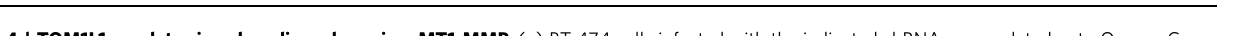
Figure 4 | TOM1L1 regulates invadopodia and requires MT1-MMP. ( a ) BT-474 cells infected with the indicated shRNAs were plated onto Oregon Green 488 gelatin-coated coverslips. After 6–24h, cells were fixed and labelled with the relevant antibodies to visualize F-actin and cortactin by confocal microscopy. Arrowheads point to actin punctiform structure (white) and degradation of the gelatin matrix (black). Inset shows higher magnification of the boxed region. Scale bar, 10 m m. ( b ) Same experiment as in a but cells were imaged using a confocal orthogonal ( x/z ) slice view. Inset shows